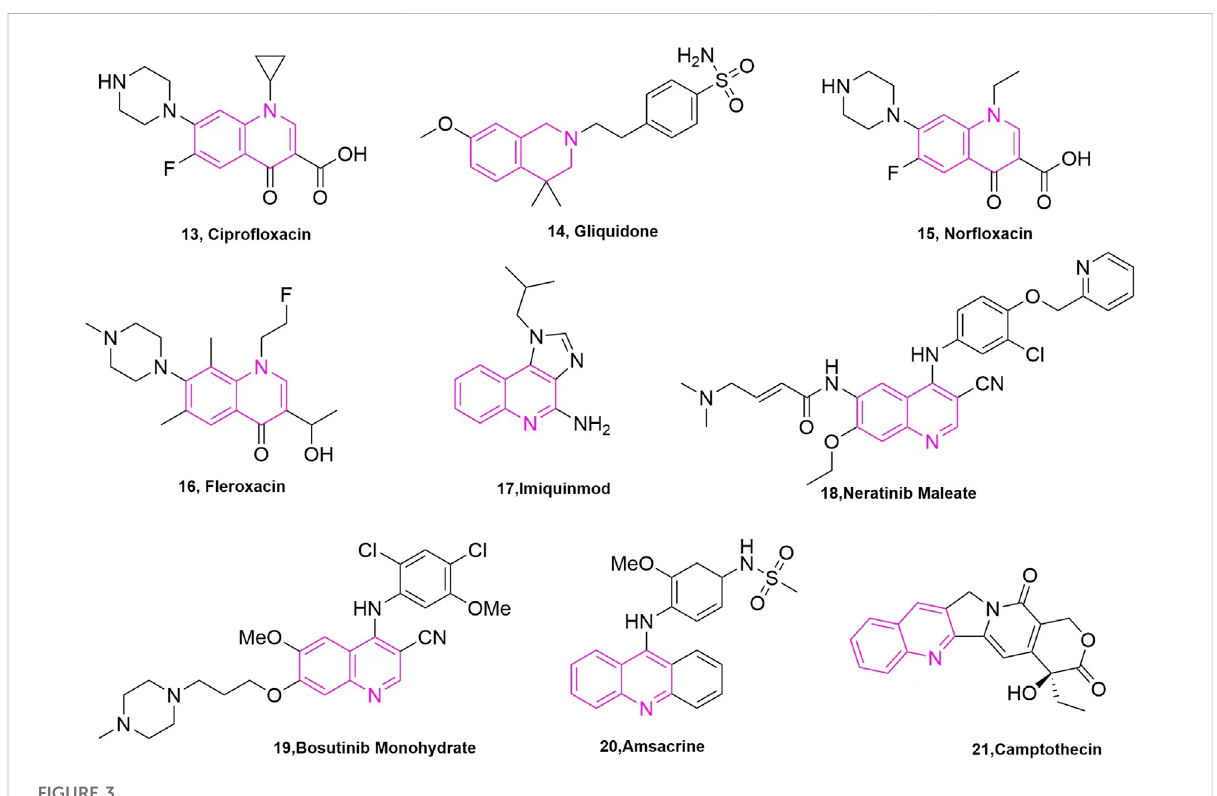
FIGURE 3 The marketed drugs carrying quinoline ’ s